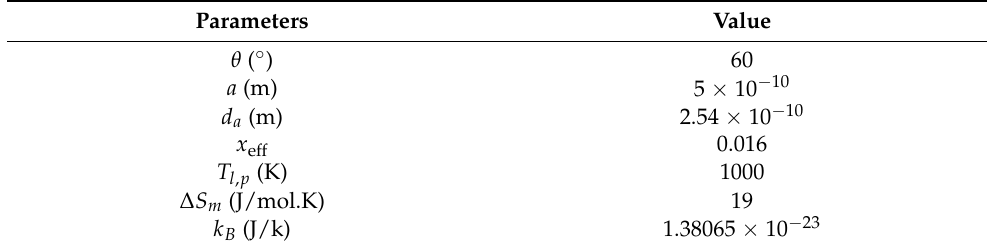
Figure 2. Calculated curves of characteristic incubation time ( τ 0 ) of competing phases. Two distin- guished cooling conditions corresponding to the formation of primary L12 and solute trapping are superimposed. An example of the evolution of the normalized particle formation time in a CA cell ( τ v ) is depicted as well (see Section 2.2). Table 1. Parameters used in the TTT model for the initiation criterion of L12